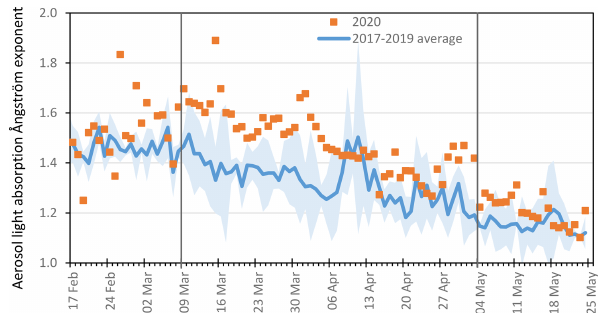
Figure 6. Percentage of sub-70nm particles in 2020 (dots) com- pared to 2017–2019 average (line). The shaded area represents ± 1 standard deviation of the average. Vertical lines indicate the begin- ning and the end of the lockdown